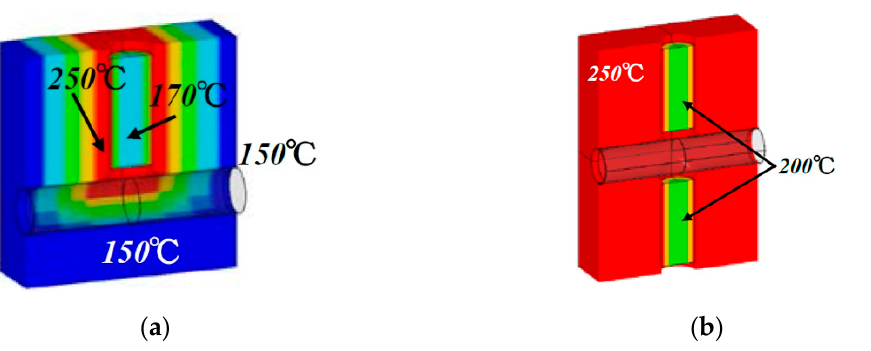
Figure 20. Optimum temperature conditions to make the wall thickness distribution more uniform. ( a ) T-shape forming for AZ61; ( b ) cross-shape forming for AZ31B and